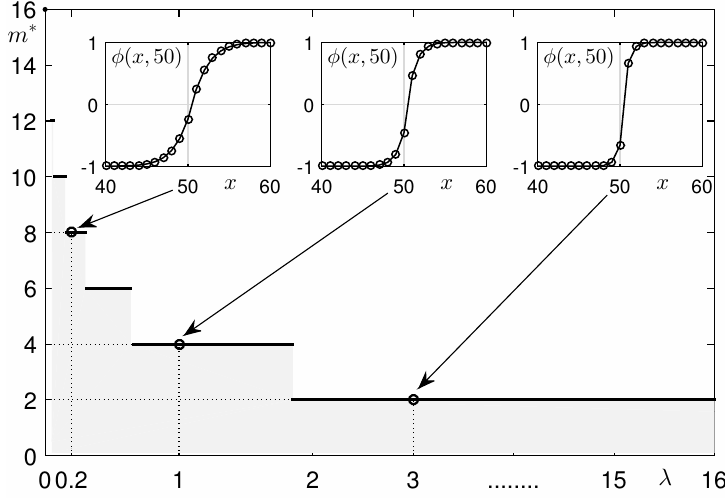
Figure 3. Numerical results at steady state for several values of λ